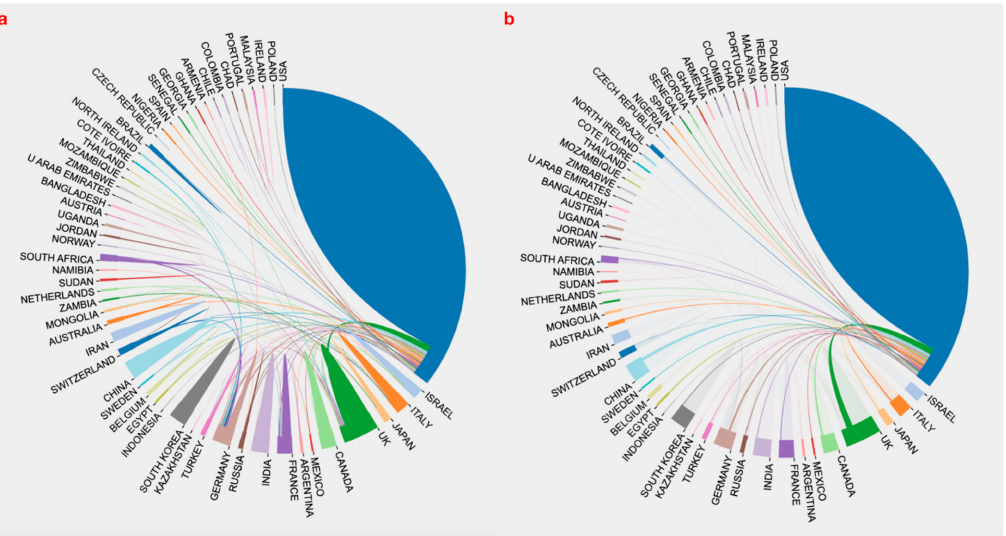
Figure 6. ( a ) Inter-countries collaboration in anthrax vaccine research, ( b ) the USA collaboration with other countries or regions.